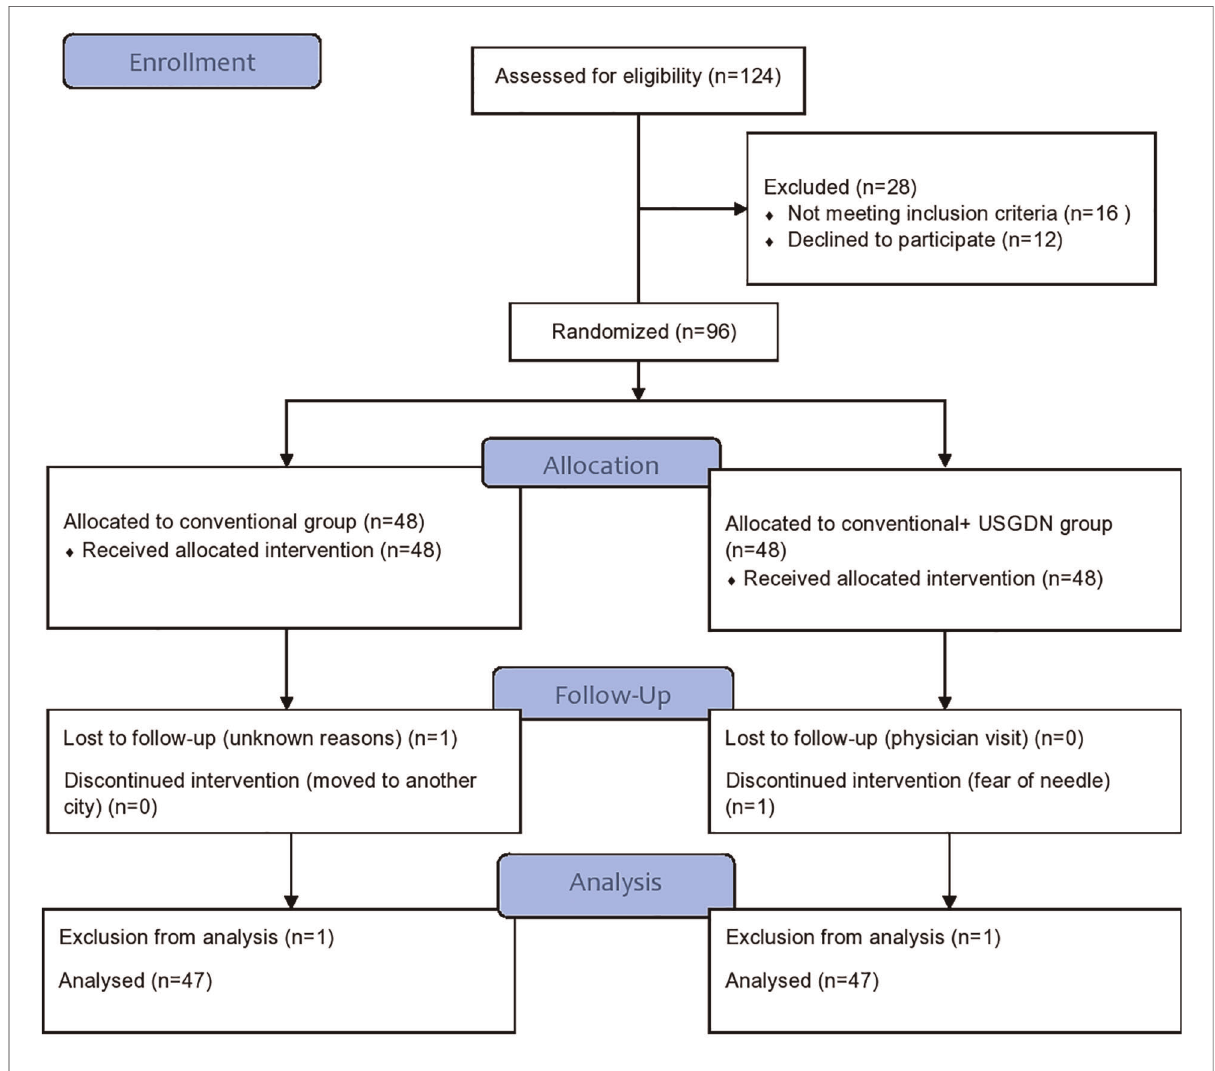
FIGURE 1 The overall summary of Consort diagram and study fl ow